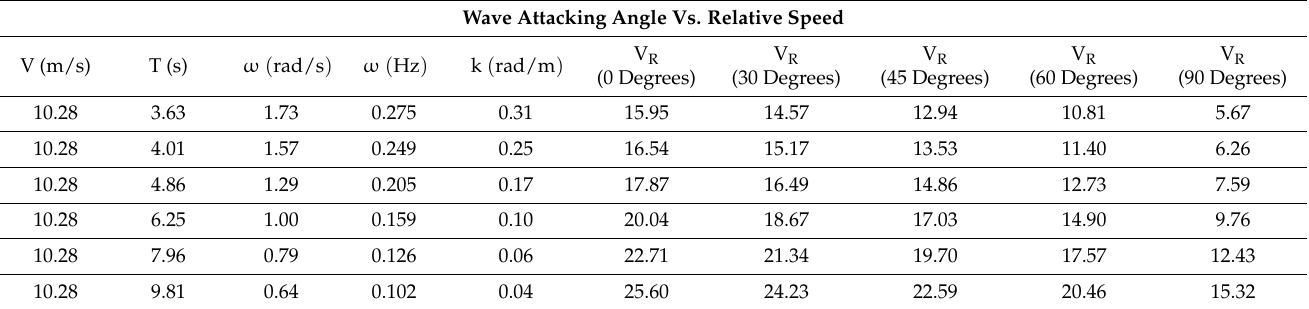
Table 4. Relative speed calculation considering wave attacking angle.